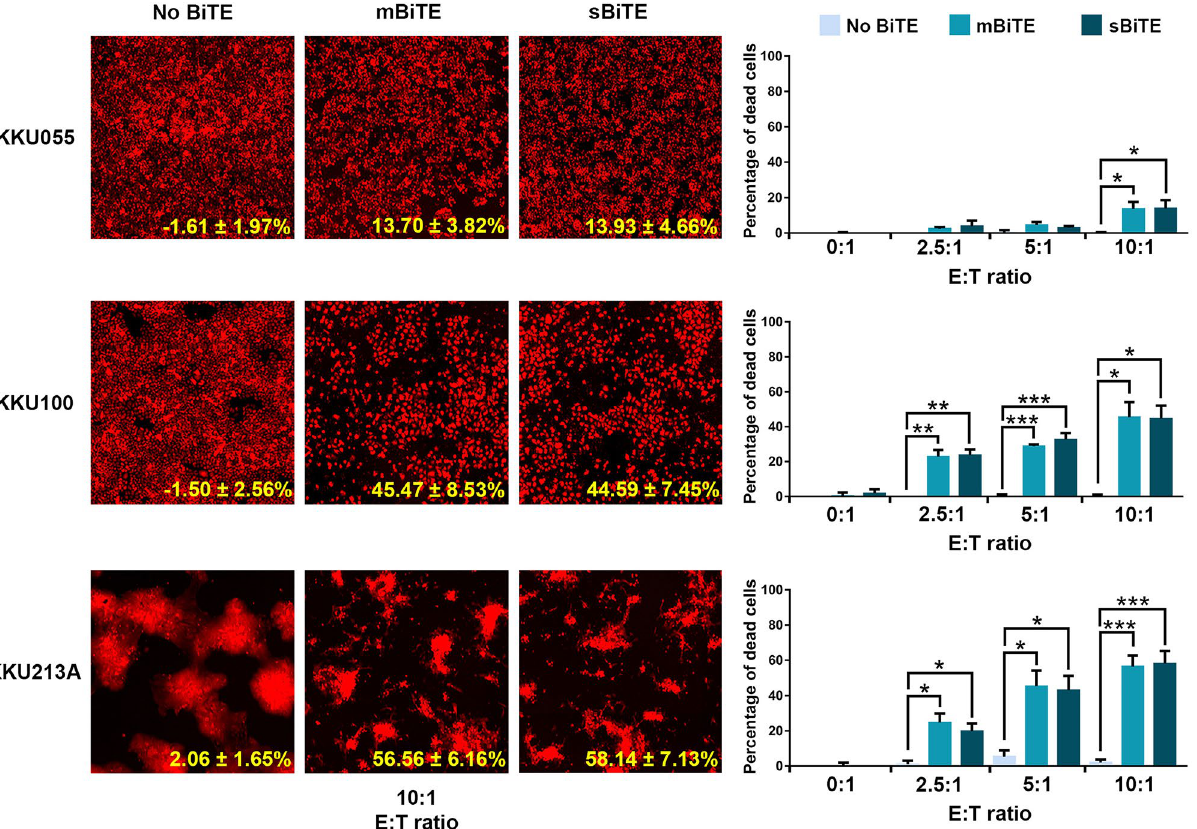
Figure 5. The effect of BiTEs on the induction of T cell cytotoxicity against CCA cells. A killing assay was performed to determine the number of remaining mCherry-expressing CCA cells after coculturing of T cells in the presence or absence of mBiTE or sBiTE. The remaining cells were observed after 24 h of coculturing under the florescence microscope at an E:T ratio of 10:1 (left). The bar graph showed the percentage of cell death relative to non-treatment control at E:T ratios of 0:1, 2.5:1, 5:1, and 10:1 (right). Data are presented as the mean ± standard error of the mean (SEM) (error bar) (* p < 0.05; ** p < 0.01; *** p <